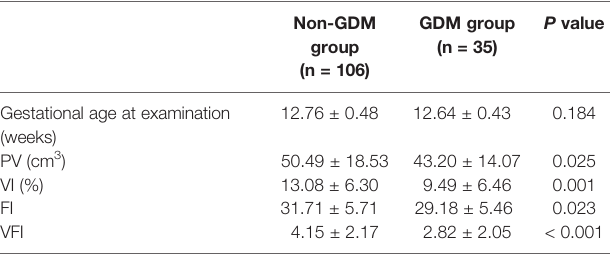
TABLE 2 | Comparison of placental volume and vascular perfusion between non-GDM group and GDM group.